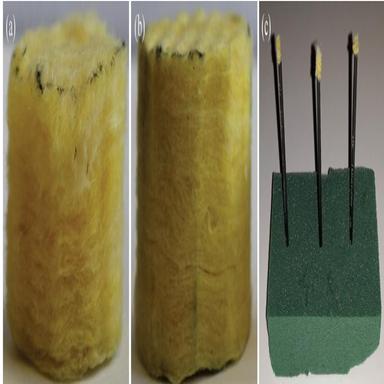
Macroscopic pictures of the glass wools (diameter = 15 mm, length = 30 mm) (a) sample 406 (b) sample 409 (c) small samples mounted on graphite sticks.